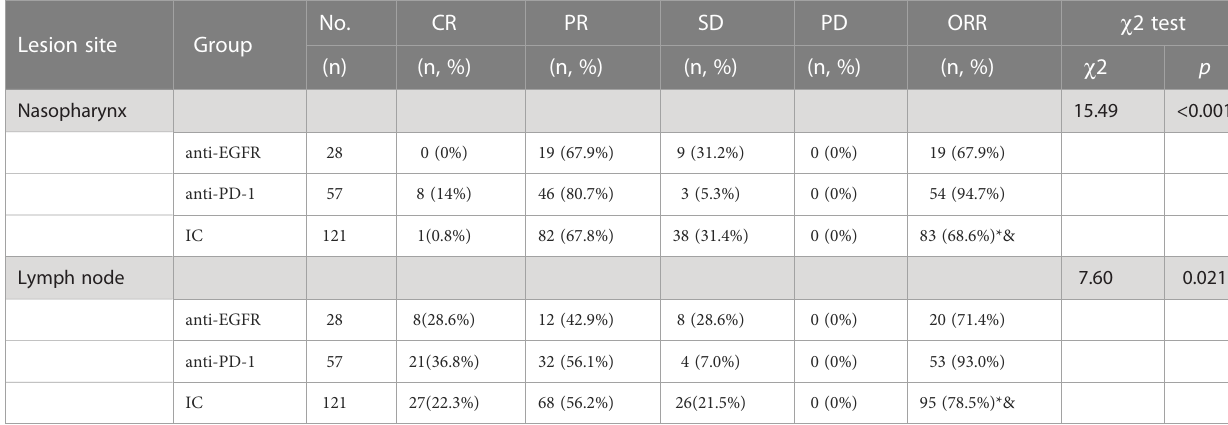
TABLE 2 Short-term ef fi cacy after induction